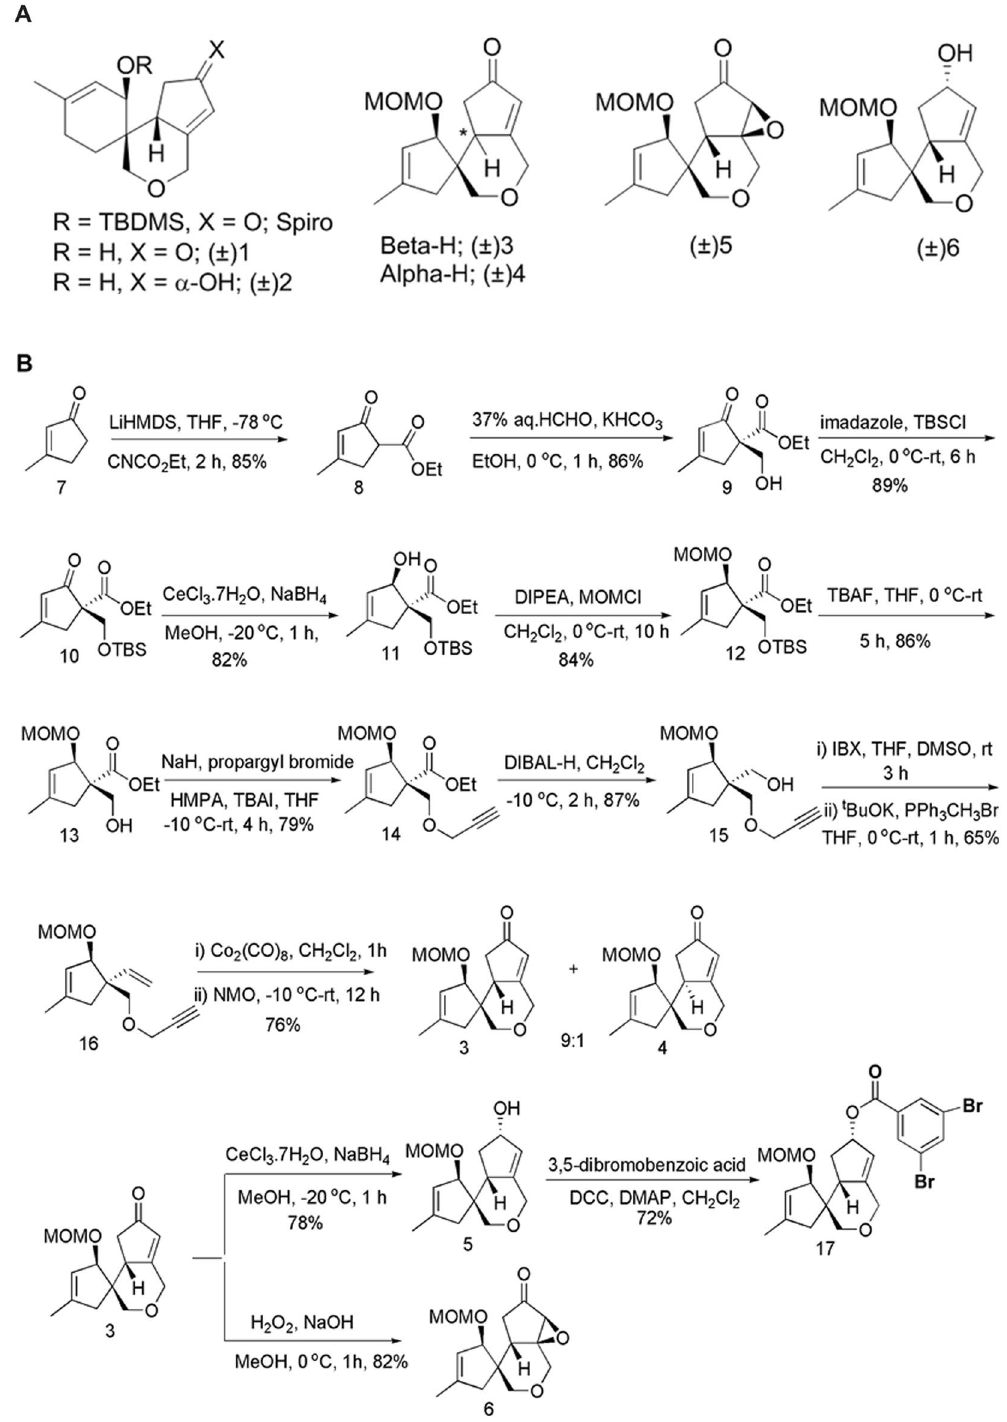
Figure 1. ( A ) Natural product inspired spiro[5.5]undecane and spiro[5.4]decane scaffolds.( B ) Scheme followed for the synthesis of spirocyclic compounds 3, 4, 5 and